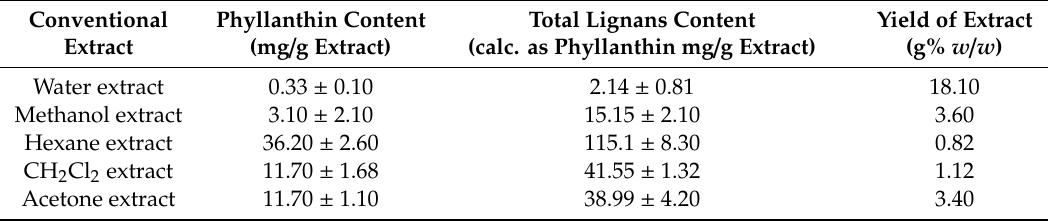
Table 1. Contents of phyllanthin and total lignans in extracts of P. niruri aerial parts, prepared by conventional methods.